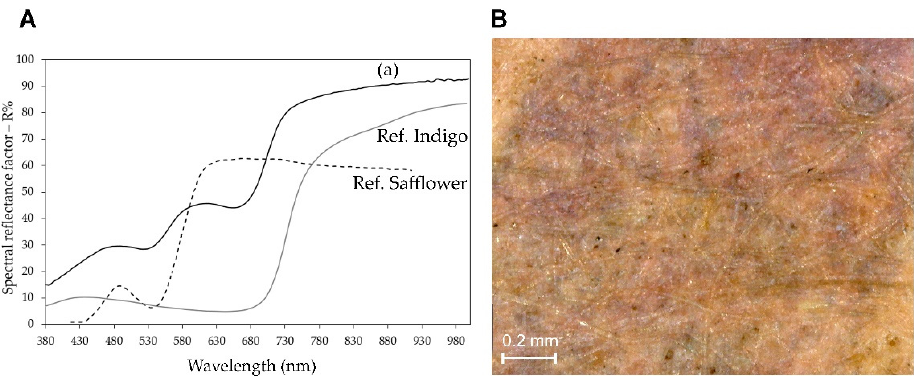
Figure 10. ( A ) FORS spectrum and ( B ) microscope image of a purple area in print 5. By analyzing FORS spectrum (a), we can assume the presence of a mixture made of blue and red pigments such as indigo and safflower. In the microscope image, we can also see blue and red areas supporting this hypothesis.